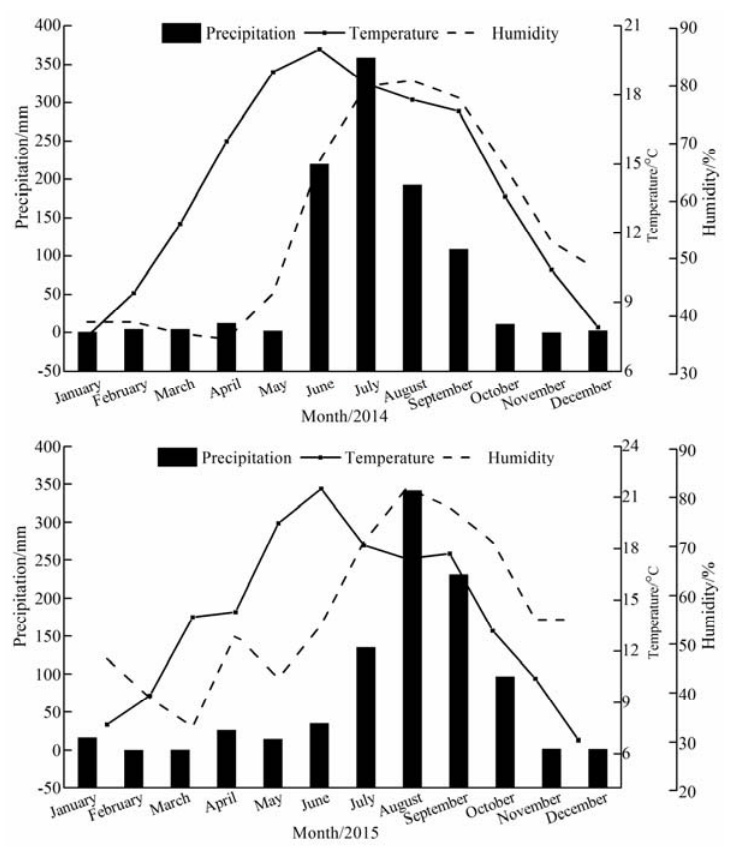
Figure 3. Precipitation, temperature and relative humidity are obtained from January 2014 to December 2015.